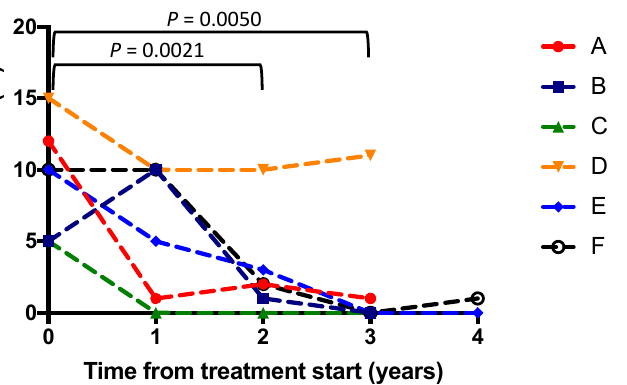
Figure 2. Change in percentage of cells showing abnormal storage inclusions after treatment for each of the six patients (A-F, labelled in separate colours as per the legend).